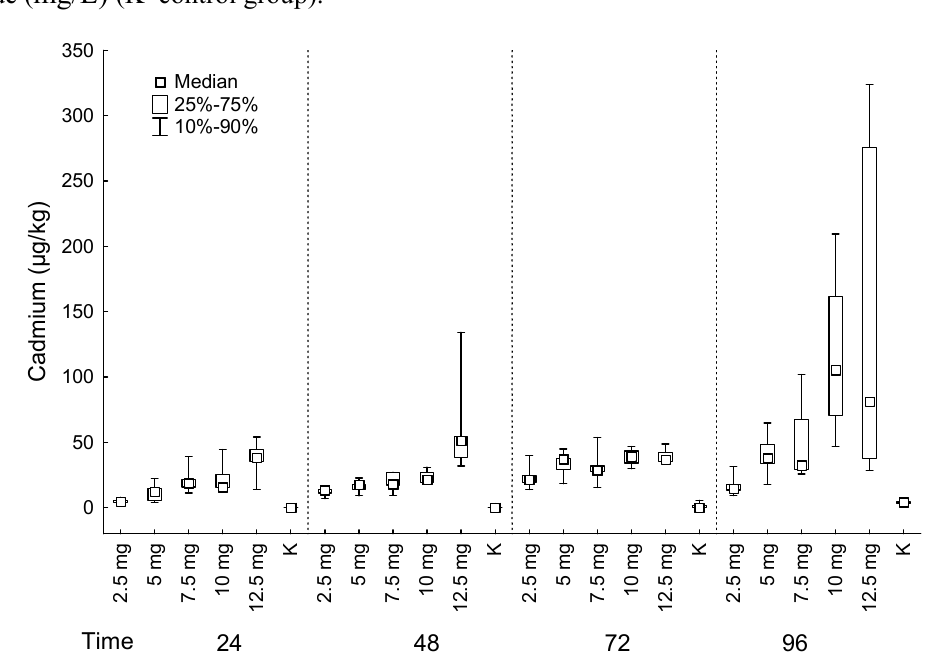
Figure 1. MUSCLE : Cadmium ( μ g/kg) in fish grouped according the exposition to cadmium chloride ( mg/L) (K–control